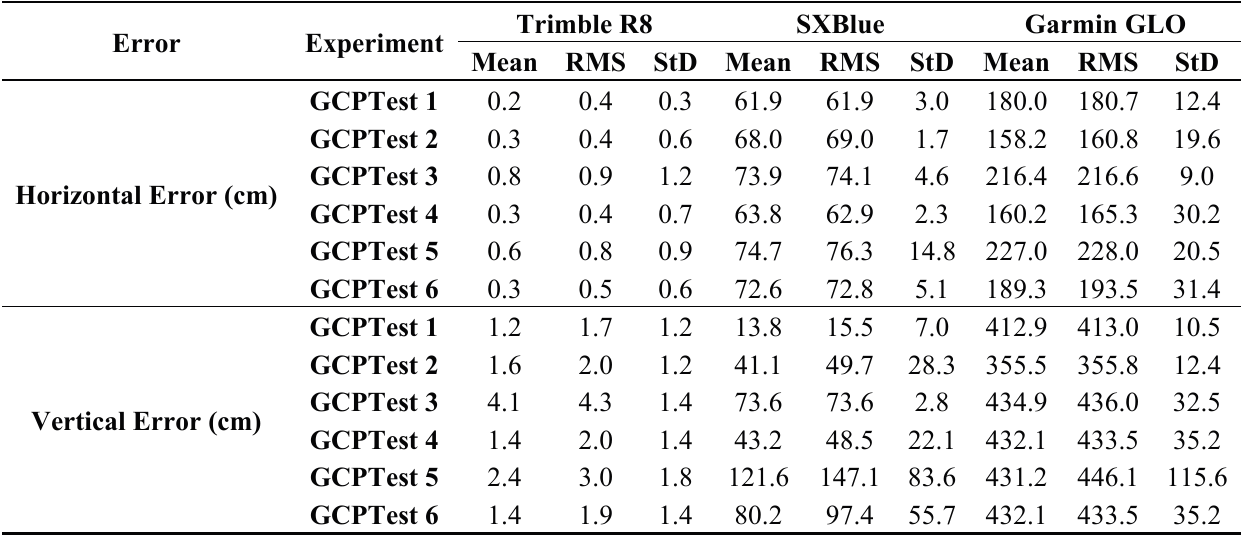
Table 5. Horizontal accuracy on checkpoints based on different GCP experiments.